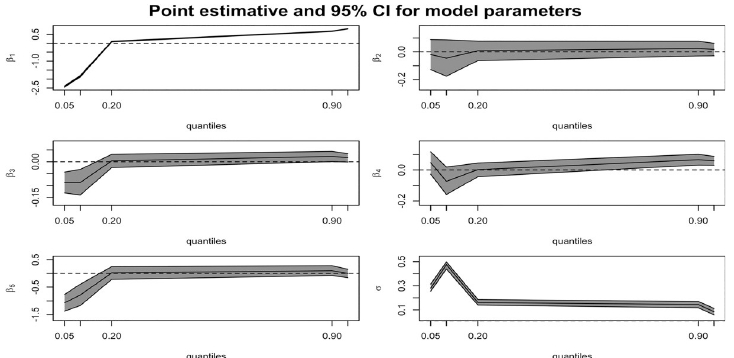
Fig 1. Estimated 95% CI for model parameters of field goals. Here, Intercept as ( β 1 ), Postseason as ( β 2 ), Away as ( β 3 ), Icing as ( β 4 ), and pressure as ( β 5